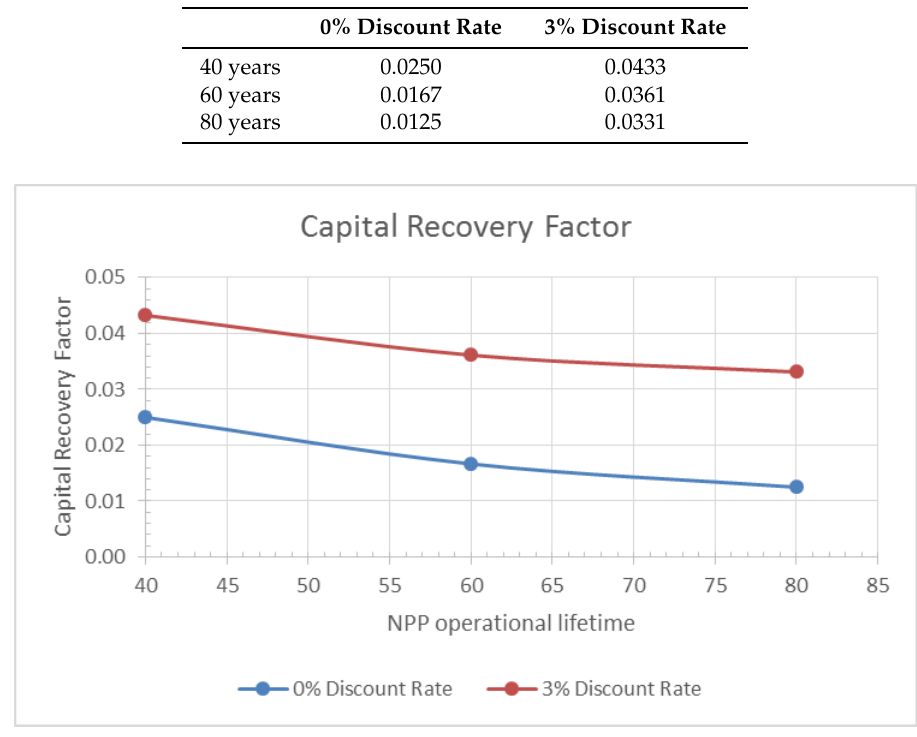
Table 4. Capital recovery factor for different nuclear power plant (NPP) operational lifetimes.